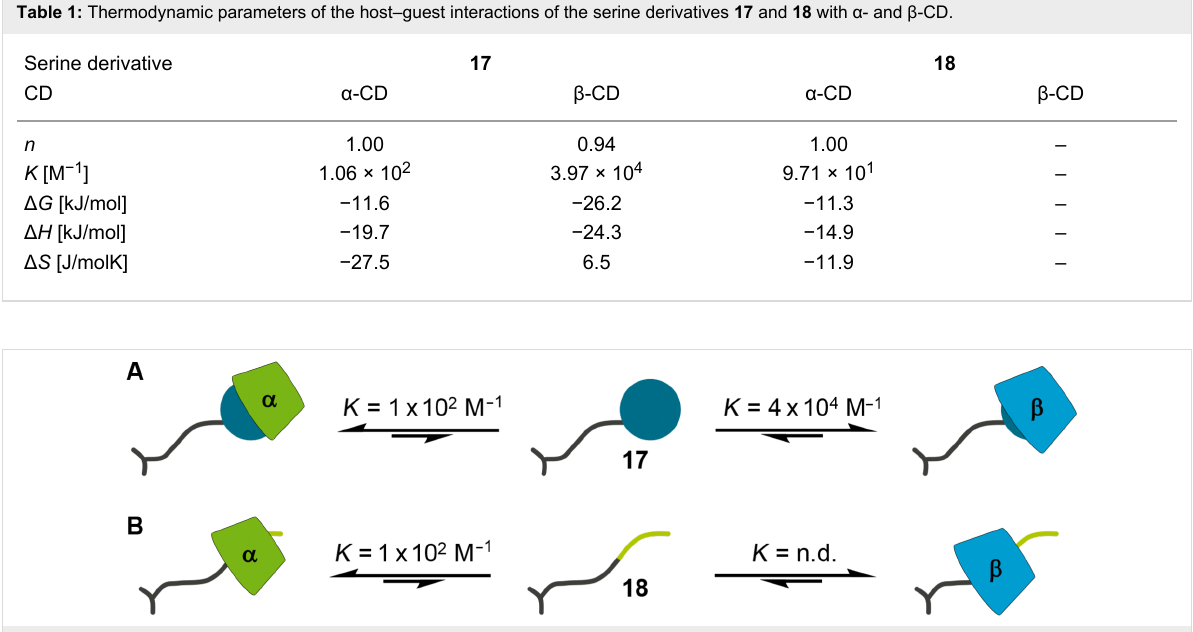
Table 1: Thermodynamic parameters of the host–guest interactions of the serine derivatives 17 and 18 with α - and β -CD. Serine derivative